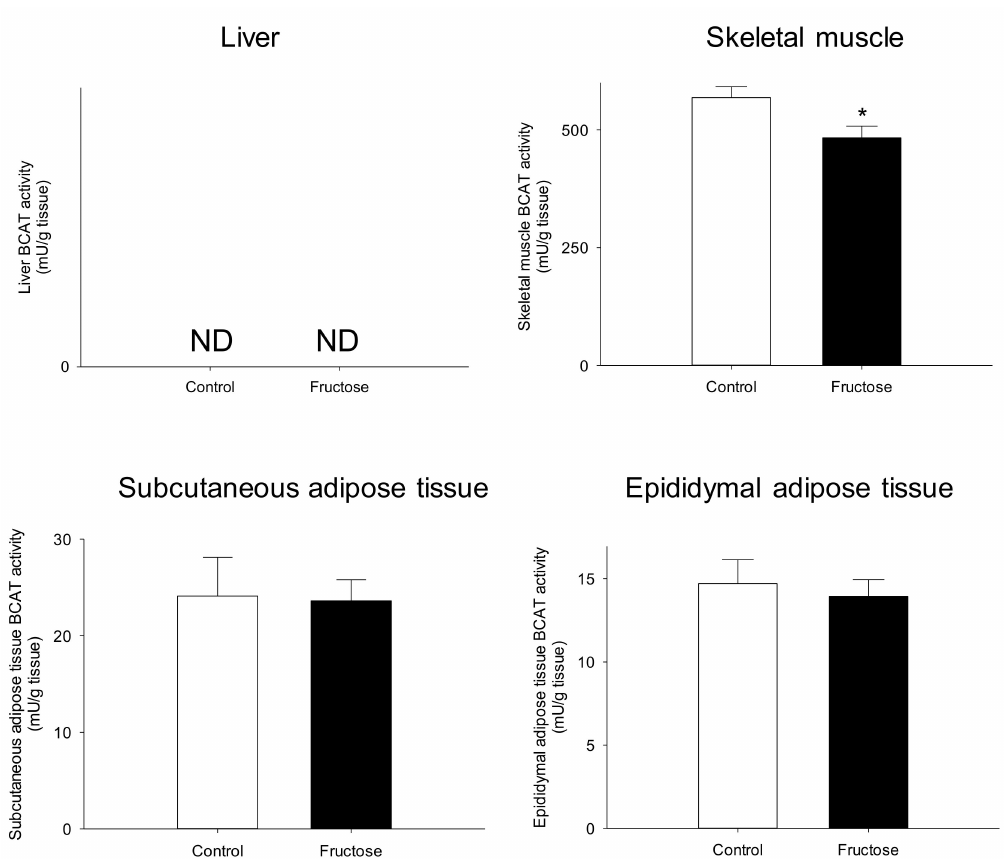
Figure 4. Branched chain aminotransferase 2 (BCAT2) activity in the liver, skeletal muscle, subcutaneous adipose tissue, and epididymal adipose tissue of rats fed on a control or high-fructose diet for 45 days. Data is presented as mean ± SEM ( n = 8). * represent significant ( p < 0 .05) differences between groups. ND, not